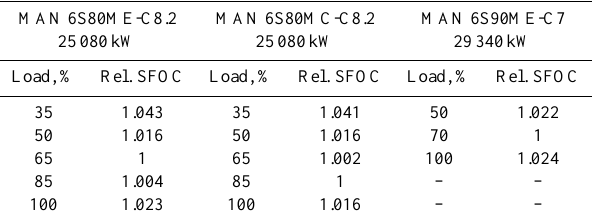
Table B2. Specific fuel-oil consumption measurements as a func- tion of engine load, extracted from MAN product guide for two- stroke engines. Data for MAN 6S90ME-C7 engine (two-stroke with fixed pitch propeller and high efficiency turbocharger) were extracted from available product specifications. Relative SFOC- values (increase of SFOC in comparison to minimum value given in product specifications) have been computed using the specified SFOC value for each engine.